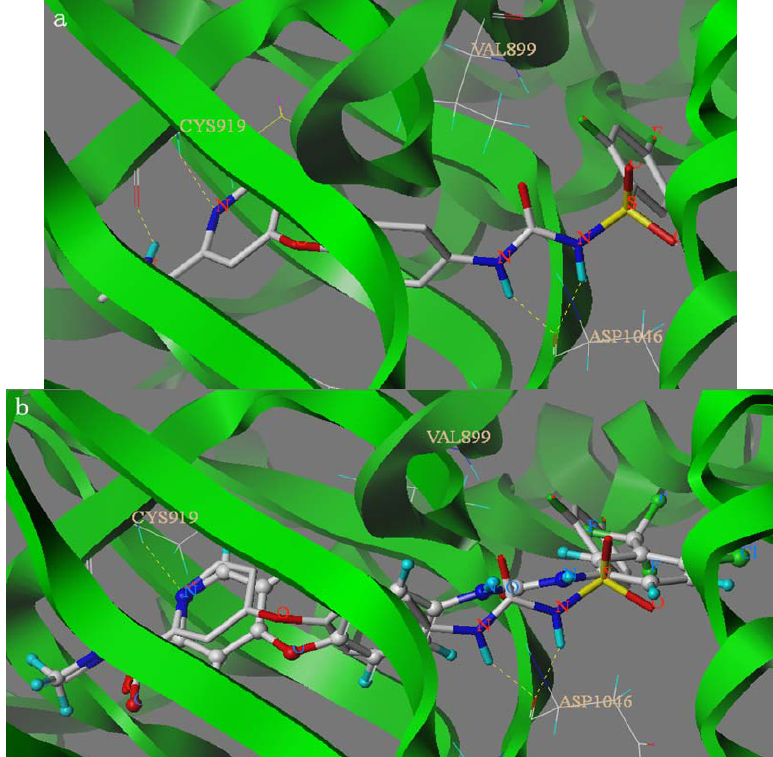
Figure 2 . Binding models of compound 6c (( a ) shown in Capped Sticks) and parent compound Sorafenib (( b ) shown in Ball and Stick) target into the active site of VEGFR2. Hydrogen bonds were showed in dashed lines